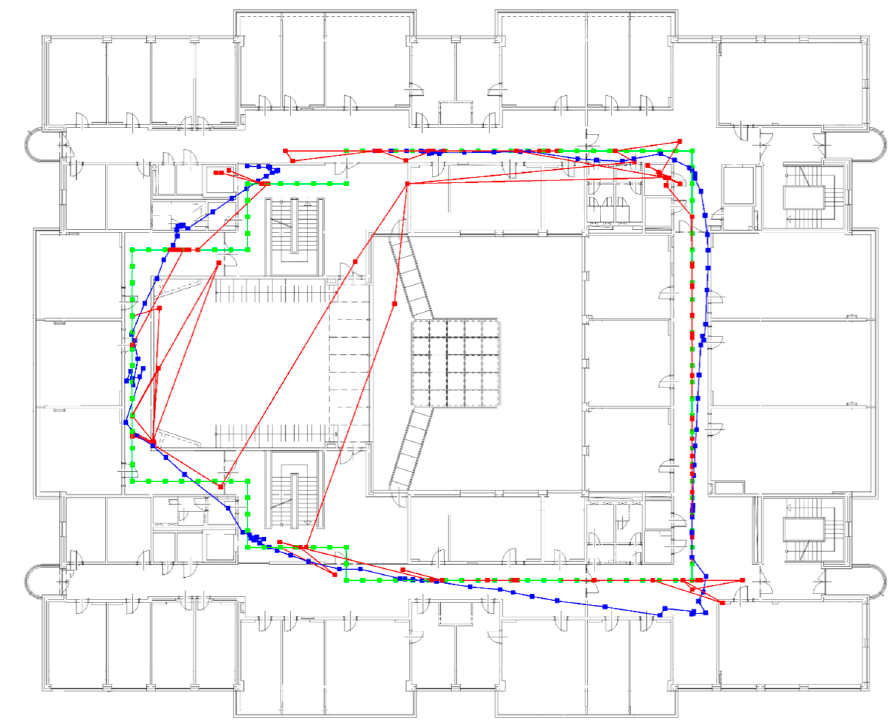
Figure 6. Visualization of test results for the Algorithm 3.